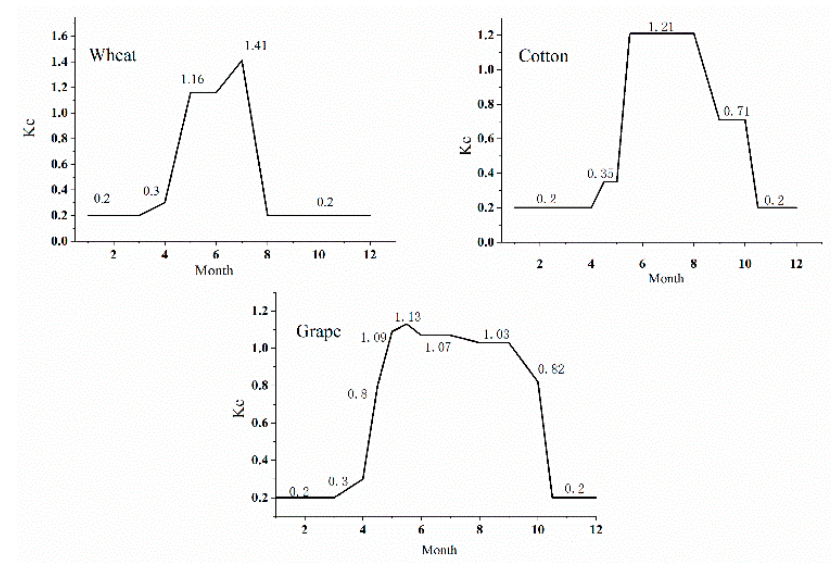
Figure 2. Crop evapotranspiration coefficients.